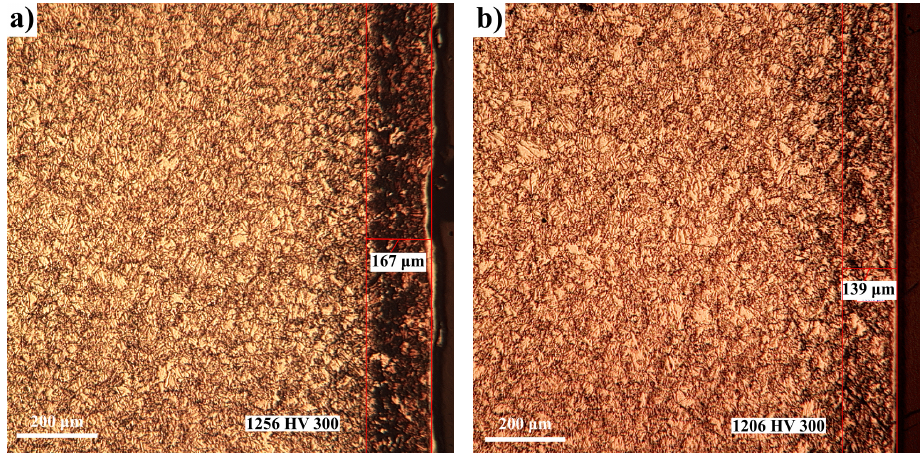
Figure 7. OM images of the 34CrAlMo5 nitralloy steel to 580 °C for 4 h holding in atmosphere of ammonia diluted with 30% N 2 ( a ), respectively, 60% N 2 ( b ); the ammonia dissociation degree: 45% ( a ) and 70% ( b ); potential of nitrogen: 1.64 ( a ) and 0.56 ( b ); nitrogen concentration in the superficial layer: 8.5% ( a ) and 7.58% ( b ). The microhardness indentations were performed at 150 microns from the surface of the layer.